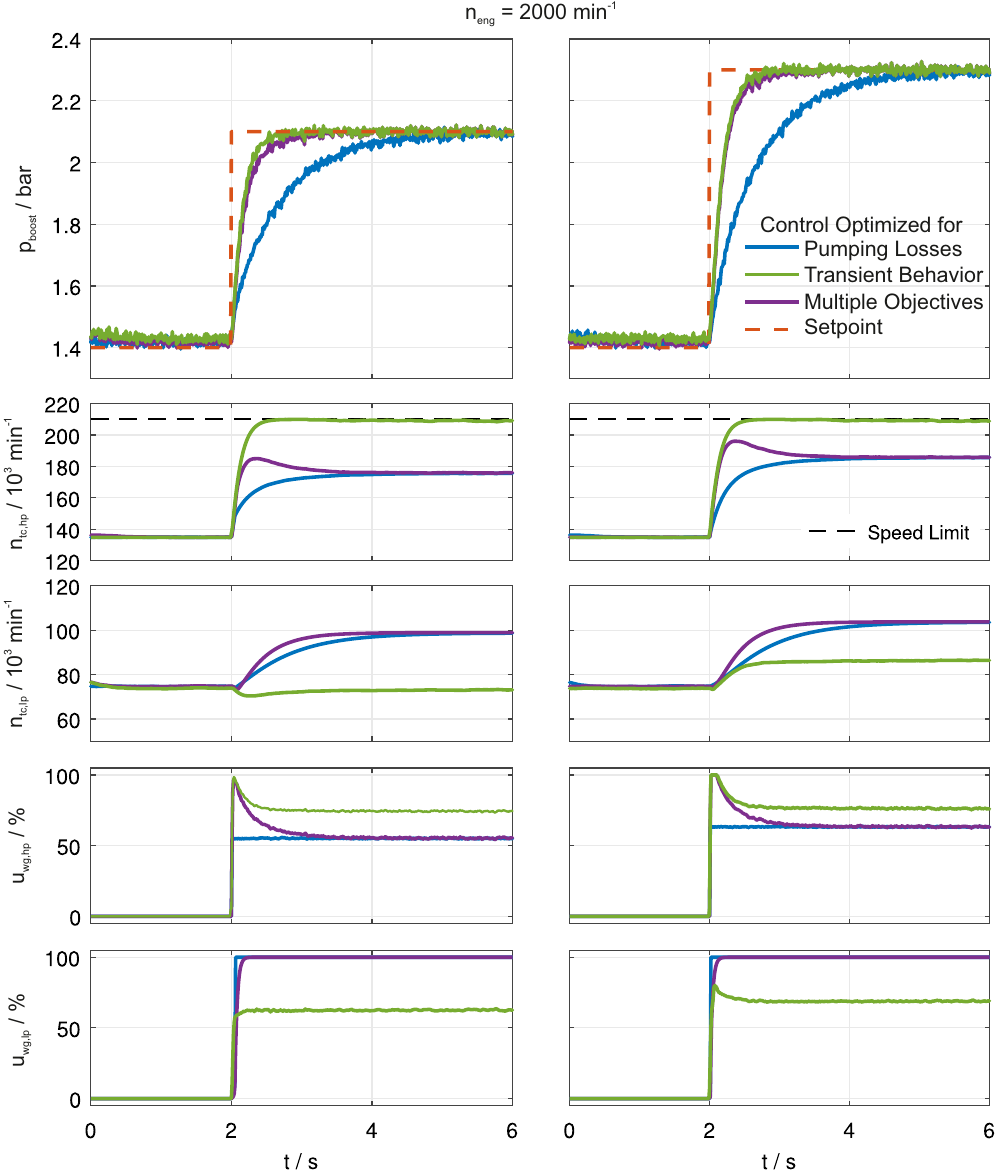
Figure 6. Closed-loop simulations. Comparison of the control strategy: (1) reduction of pumping losses; (2) fast response; (3)